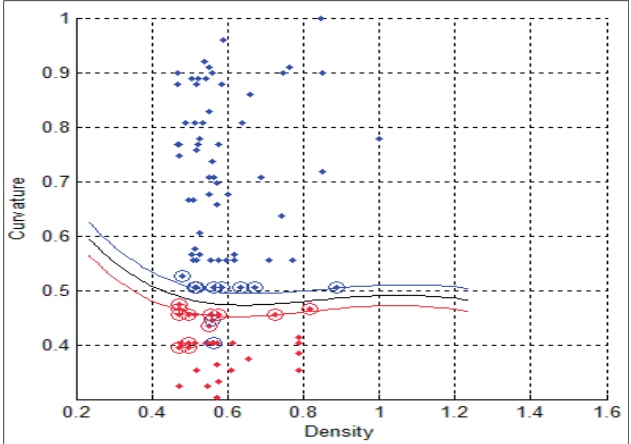
Figure 15. SVM separation for benign and malignant classes by using density and curvature features (strong class overlap). Red points corresponding to benign cells and blue points corresponding to malignant cells. The black line represent the margin.